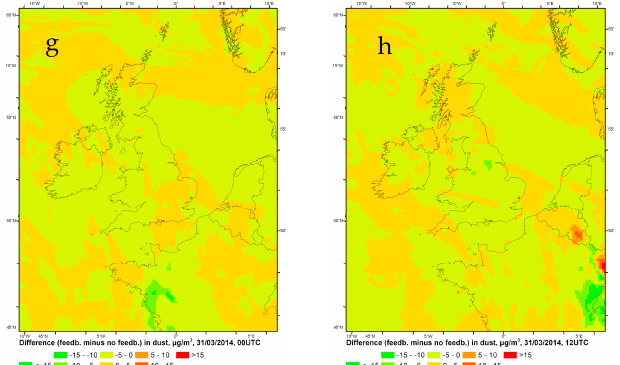
Figure 6. Calculated difference in dust concentrations (ug/m 3 ) using the option with radiation feedback and without radiation feedback during four days ( a – h ) 29 March–1 April 2014 with a 12-h interval going from the top left to lower right.